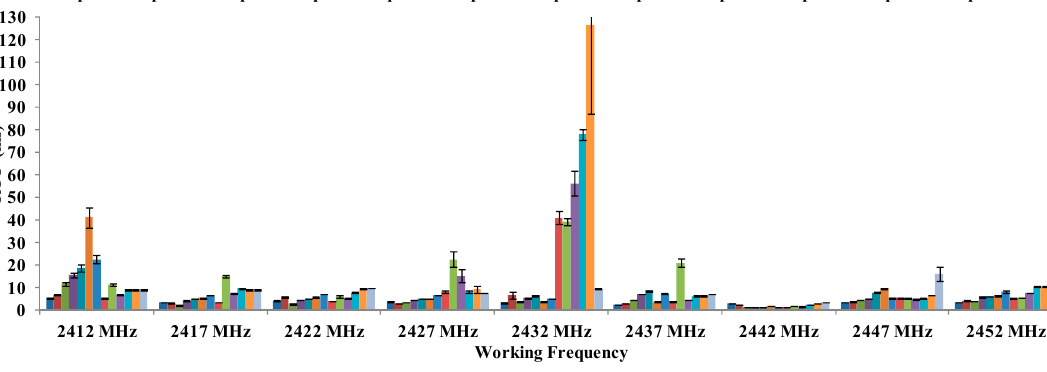
Figure 15. Values of RTT in ms for 16 °C.